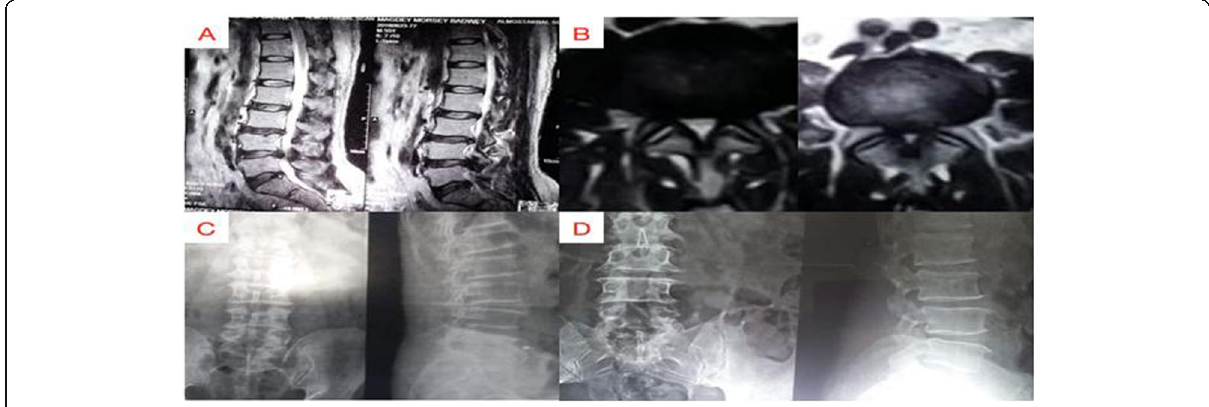
Fig. 3 Sagittal and axial T2WI MRI images are showing multiple level discogenic with ligamentum stenosis and spinal stenosis ( a and b ). Preoperative radiograph [lateral and AP views] is showing no spinal instability ( c ). PO radiograph [AP and lateral views] showed double levels of conventional